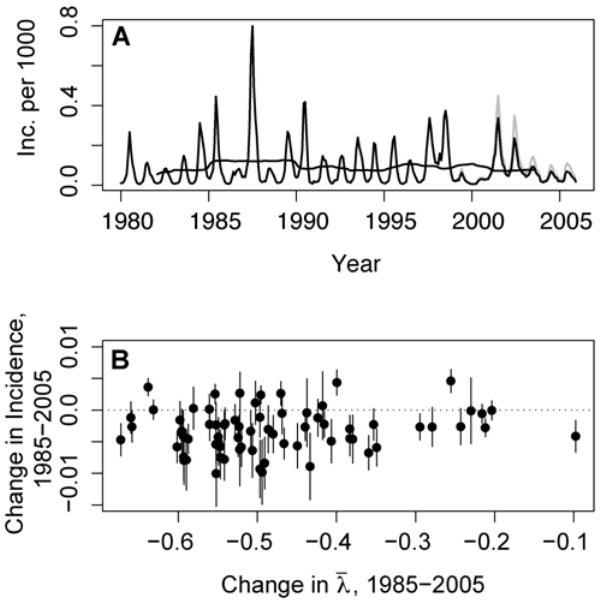
Figure 4. Incidence of dengue disease in Thailand, 1981–2005. (A) Incidence of dengue disease in Thailand, 1981–2005. The solid line shows the incidence per 1,000 individuals per year of DHF and DSS together, whereas the grey line shows the incidence of DHF, DSS, and DF. DF was included in case reports starting in 1993. (B) Change in incidence (per 1,000 per year) 1985–2005 with 95% CI versus change in force of infection for each of the provinces of Thailand. A linear association between these two variables is not statistically significant.